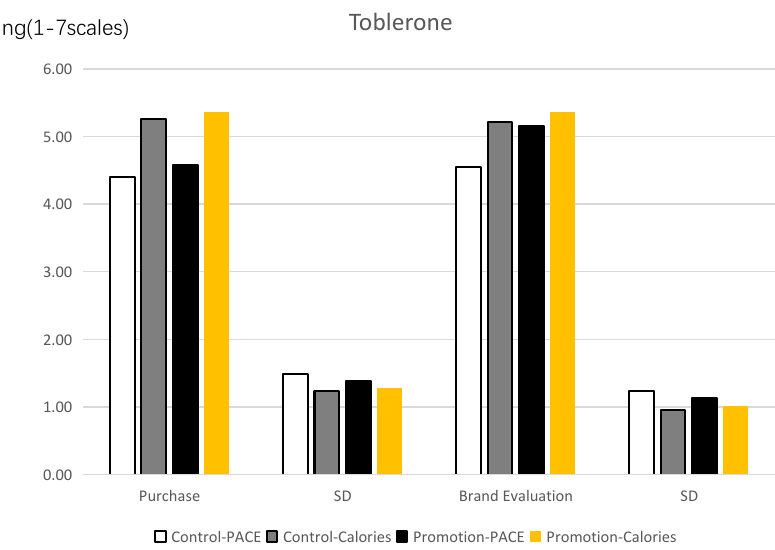
Figure 7. Effects of labels on the purchase intention and food brand evaluation.